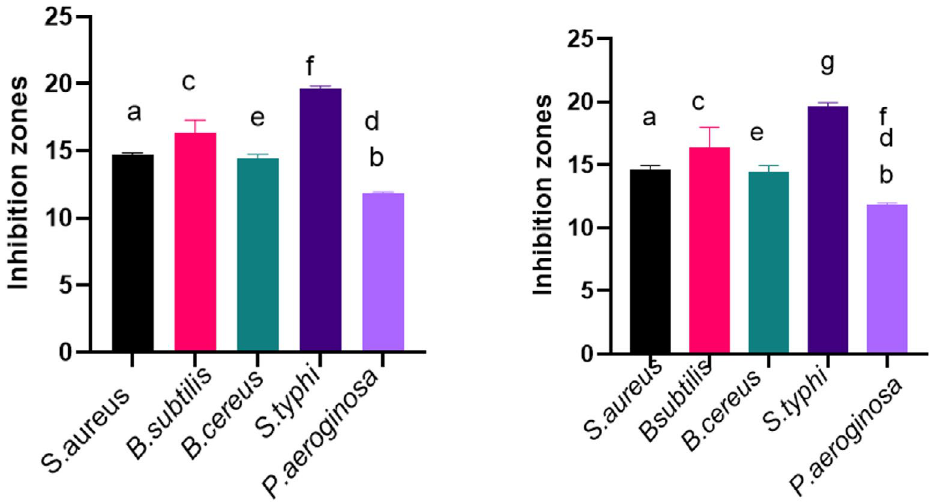
Fig. 3 & 4. Antibacterial activity of Methanol extract (Fig:3) and Acetone extracts (Fig :4) of T.catappa on human pathogenic bacteria (MTCC). Data are represented in mean ±SEM. Different letters in the bars indicate statistical difference (P<0.05). Error bars signify standard error. Inhibition zones are presented in millimeter